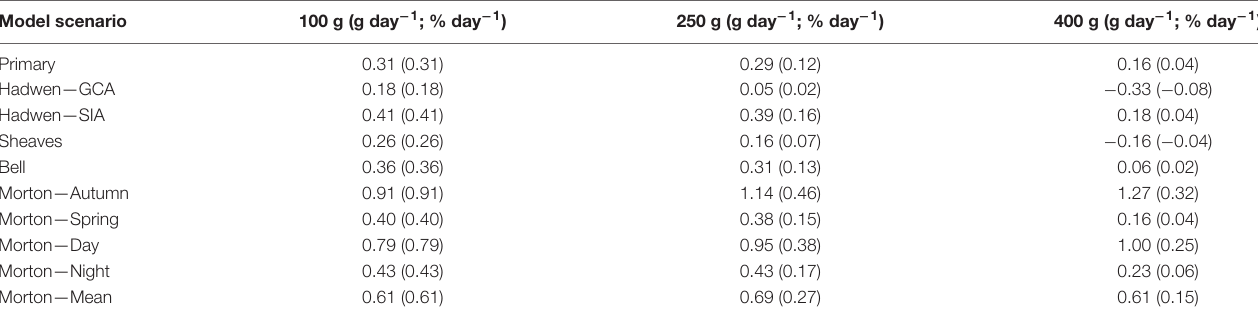
TABLE 4 | Growth rates (g day − 1 ; % day − 1 in parentheses) for each model scenario when consumption (in mass) is held constant, at different size